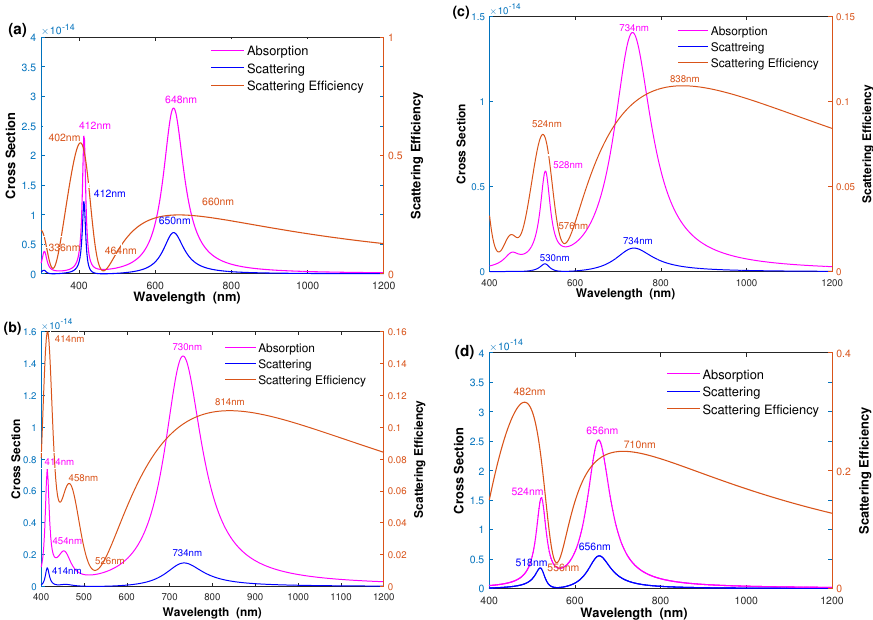
Figure 2. The spectra of absorption, scattering, and scattering efficiency are plotted as a function of wavelength. ( a ) Silver–dielectric–silver nanoshell, ( b ) silver–dielectric–gold nanoshell, ( c )